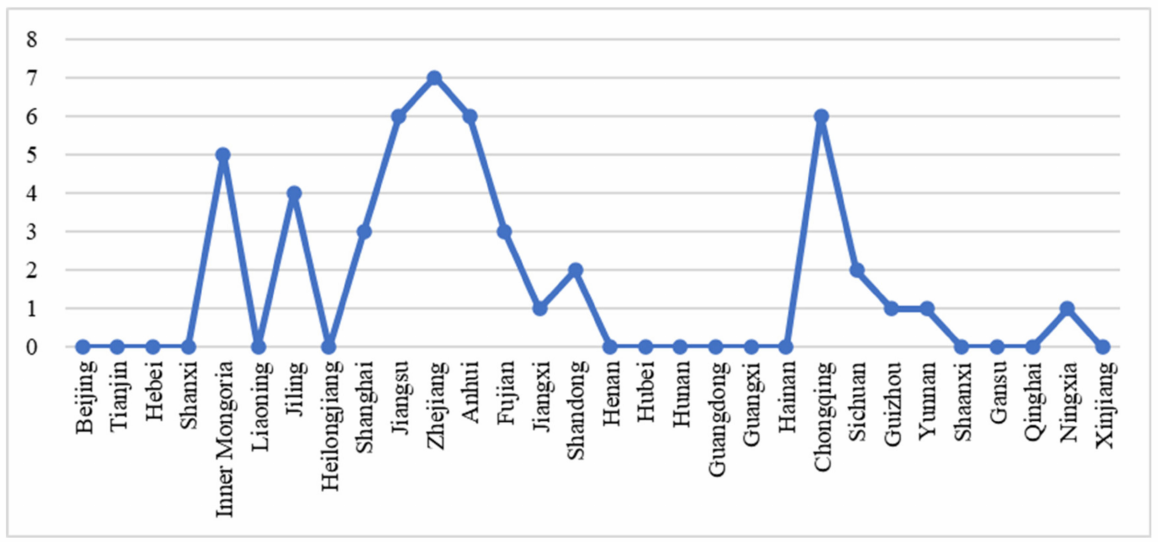
Figure 1. Initial intensity of national fitness policies in China in